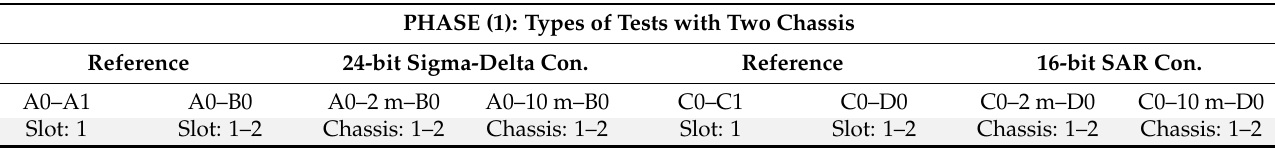
Table 1. Classification of two-chassis test types.